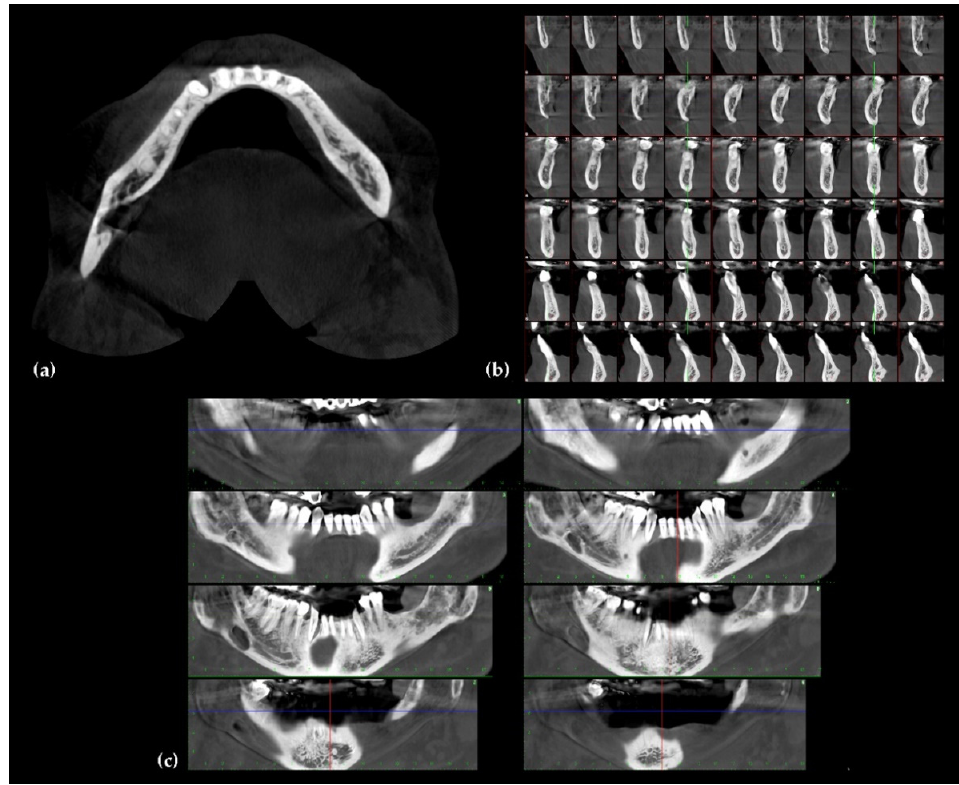
Figure 8. A cone beam computed tomography (CBCT) multiplanar reconstruction of lower jaw: ( a ) axial view, ( b ) sagittal view, and ( c ) coronal view.